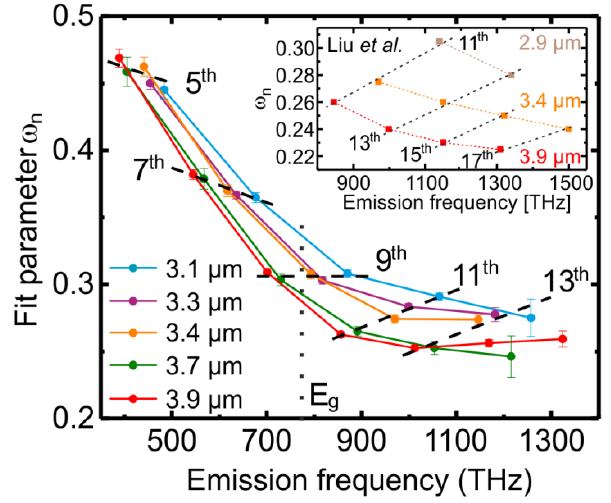
Figure 5. Sensitivity of HHG from a ZnO thin film on the laser ellipticity as a function of the harmonic order and the emission frequency for five laser wavelengths. The laser intensity in the experiment was fixed to 0.39 TW/cm 2 . The inset depicts simulations performed by Liu et al. [22]. According to simulations, the below band gap higher harmonics are dominantly gen ‐ erated by intraband transitions [9,22]. The intraband higher harmonic spectrum is defined by the Fourier transformation of the temporal derivative of the intraband current that can = e (cid:3031)(cid:3115)⃗ 𝐸(cid:4652)⃗ dt (cid:3404) (cid:3032) ∆𝐸 (cid:3034)(cid:2879)(cid:2869) (cid:3627) (cid:4666)𝑡(cid:4667) [20], given by the product from the band struc ‐ be calculated as (cid:3038)(cid:4652)⃗(cid:2880)(cid:3038)(cid:4652)⃗(cid:4666)(cid:3047)(cid:4667) (cid:3013) (cid:3031)(cid:3047) ћ ture curvature and the laser field strength 𝐸(cid:4652)⃗ (cid:3013) (cid:4666)𝑡(cid:4667) . Figure 4b shows the electron trajectory within half an optical cycle in the reciprocal space generated by 3.1 (black dashed line) and 3.9 μ m laser light fields (red dotted lines) with an intensity of 0.35 TW/cm 2 corre ‐ sponding to 0.15 V/Å field strength and a laser ellipticity of 0.5. Here, the Bloch accelera ‐ (cid:3047) (cid:3032) (cid:1516) 𝐸(cid:4652)⃗ (cid:3013) (cid:4666)𝑡′(cid:4667)𝑑𝑡 ′ tion theorem 𝑘(cid:4652)⃗(cid:4666)𝑡(cid:4667) (cid:3404) was used to determine the electron quasi (cid:3047) (cid:3116) ћ